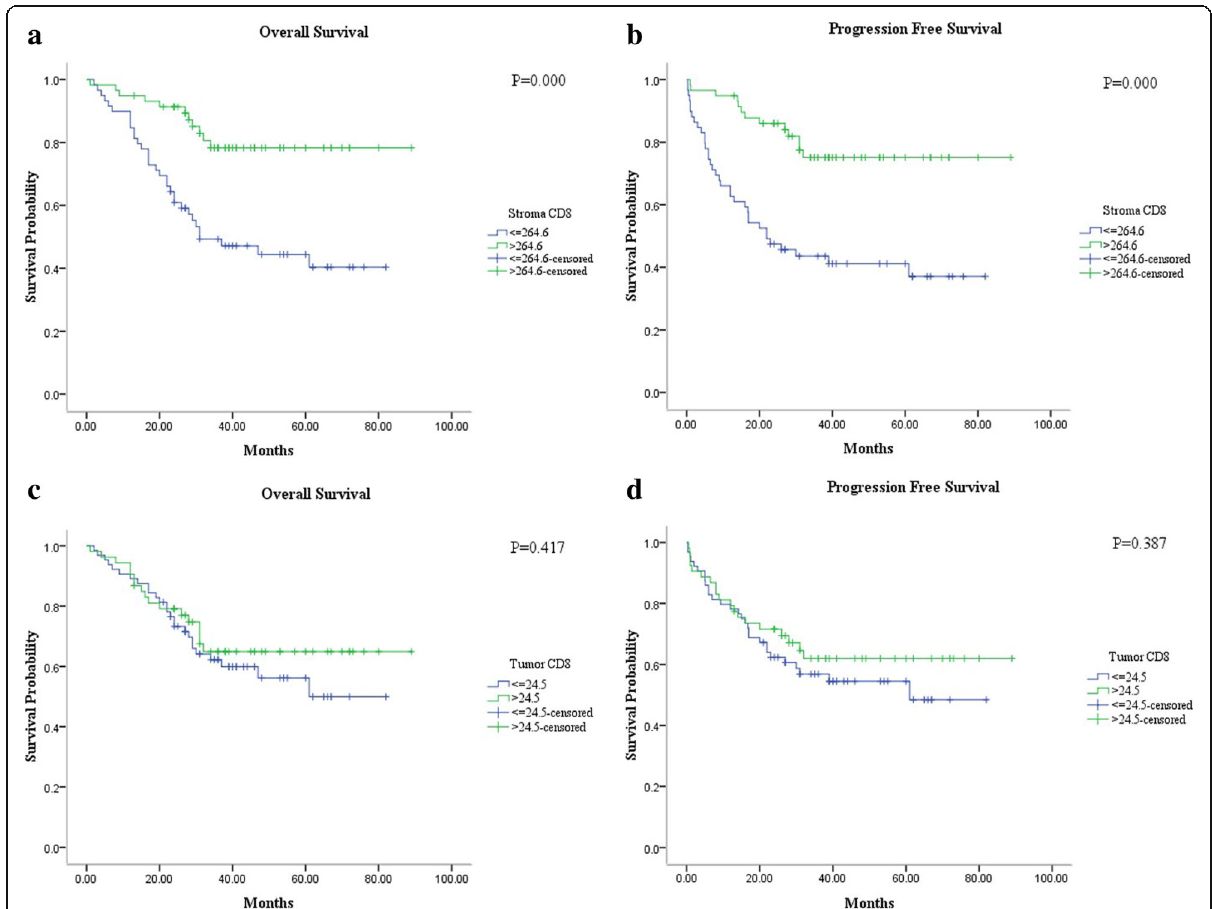
Fig. 3 In PNETs, Kaplan-Meier analysis of OS and PFS associations with CD8+ T cell density within stroma ( a - b ) and intratumor ( c - d ) were performed. Increasing stromal CD8+ T cell density is correlated with improved OS ( p = 0.000) ( a ) and PFS ( p = 0.000) ( b ), while the higher intratumoral CD8+ T cell density was associated with a trend toward improved prognosis ( c and d